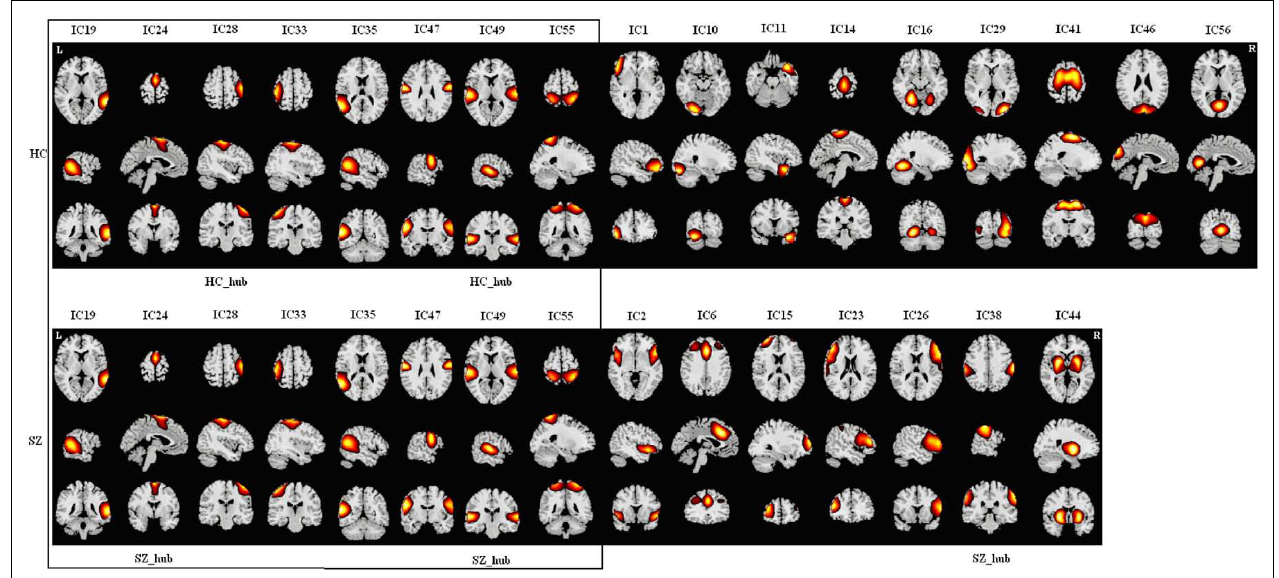
component, one motor component, and one frontal component. SZs have another seven components including one putamen component, one temporal-frontal component, one central component, one cingulum component, and three frontal components. As the components of this module in HCs are distributed across almost the whole brain, we designated this module as “Global Module” (G2 Module) as well.There are two hubs in HCs and three hubs in SZs.